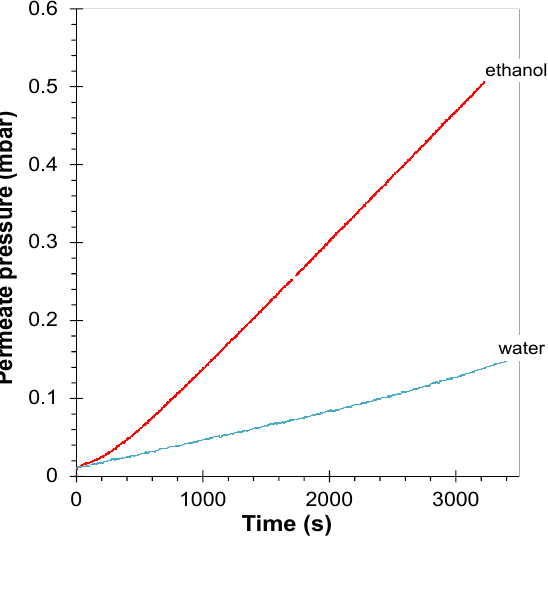
Figure 10. Time lag measurement of a neat EOC membrane with water vapor ( p / p = 0.65) and with ethanol vapor ( p / p 0